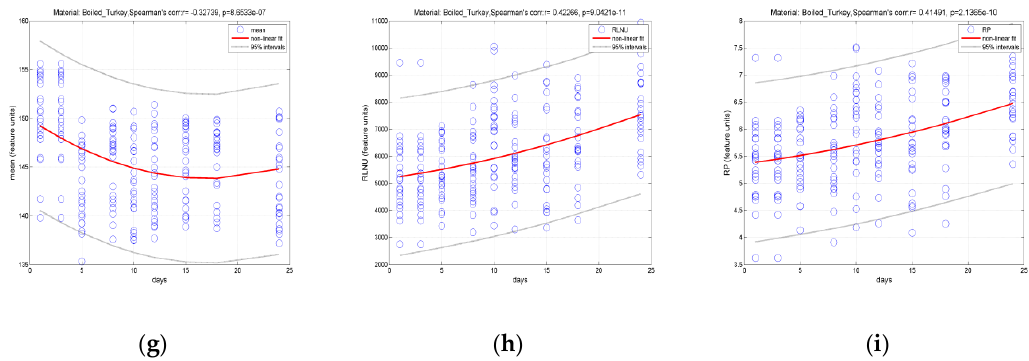
Figure A3. Variation of features ( a ) contrast, ( b ) correlation, ( c ) difference entropy, ( d ) difference variance, ( e ) great level non-uniformity, ( f ) inverse different moment, ( g ) mean intensity value, ( h ) run length non-uniformity and ( i ) run percentage of boiled turkey hams during refrigerator storage.